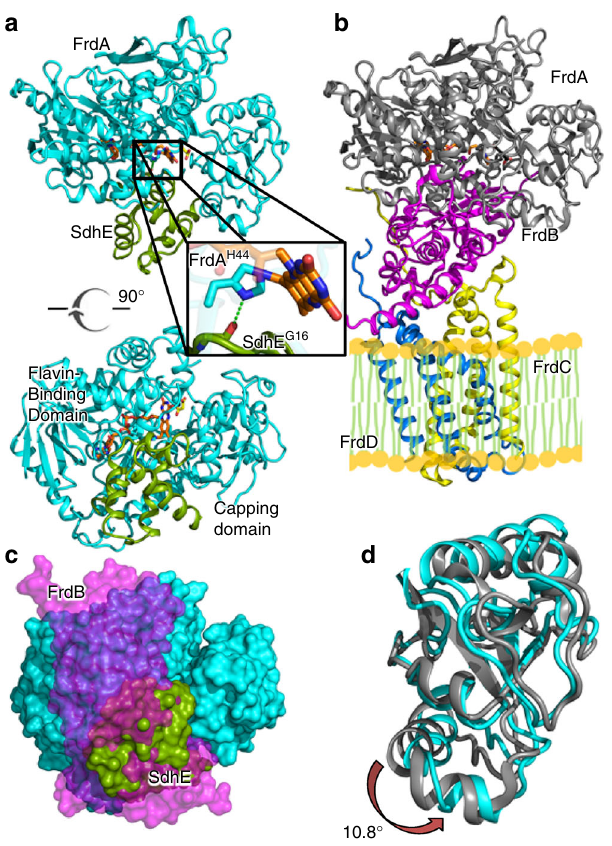
Fig. 1 Structure of the FrdA-SdhE assembly intermediate. a Two orthogonal views of the E. coli FrdA-SdhE assembly intermediate; FrdA (cyan), SdhE assembly factor (green) FAD (orange sticks), and malonate (yellow